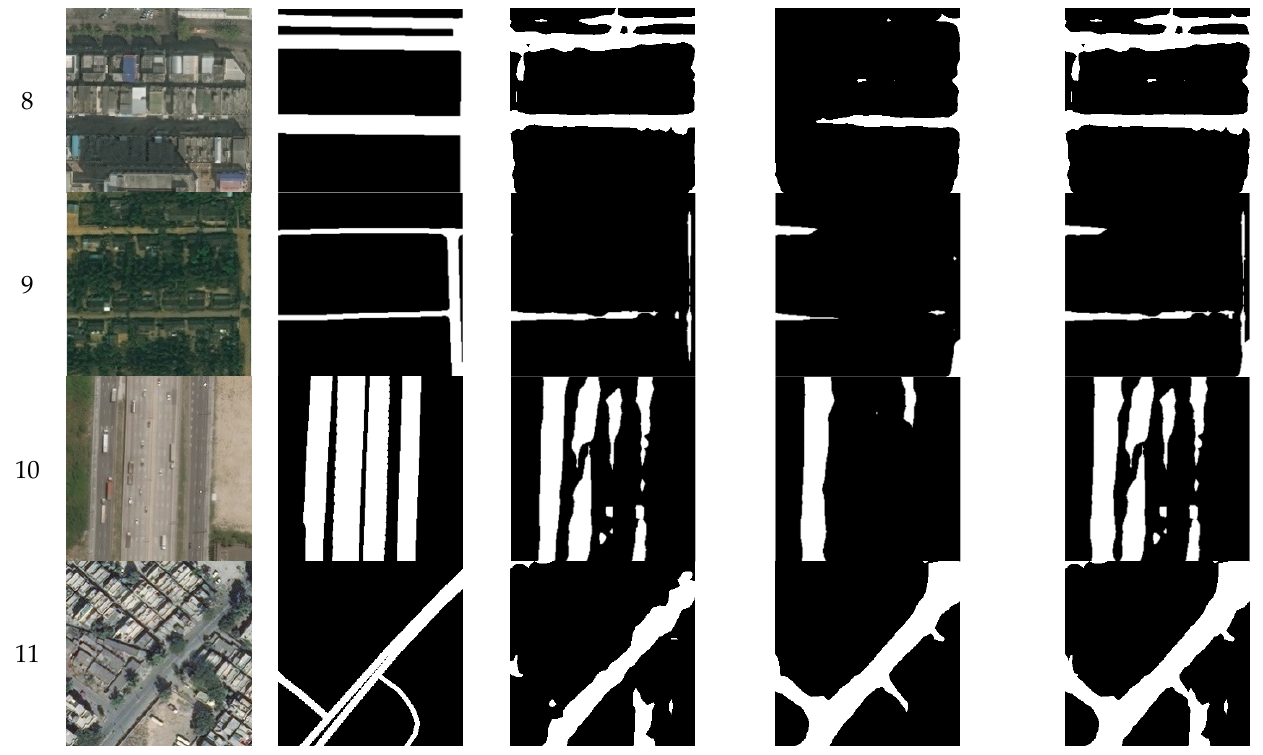
Figure 28. Typical examples.